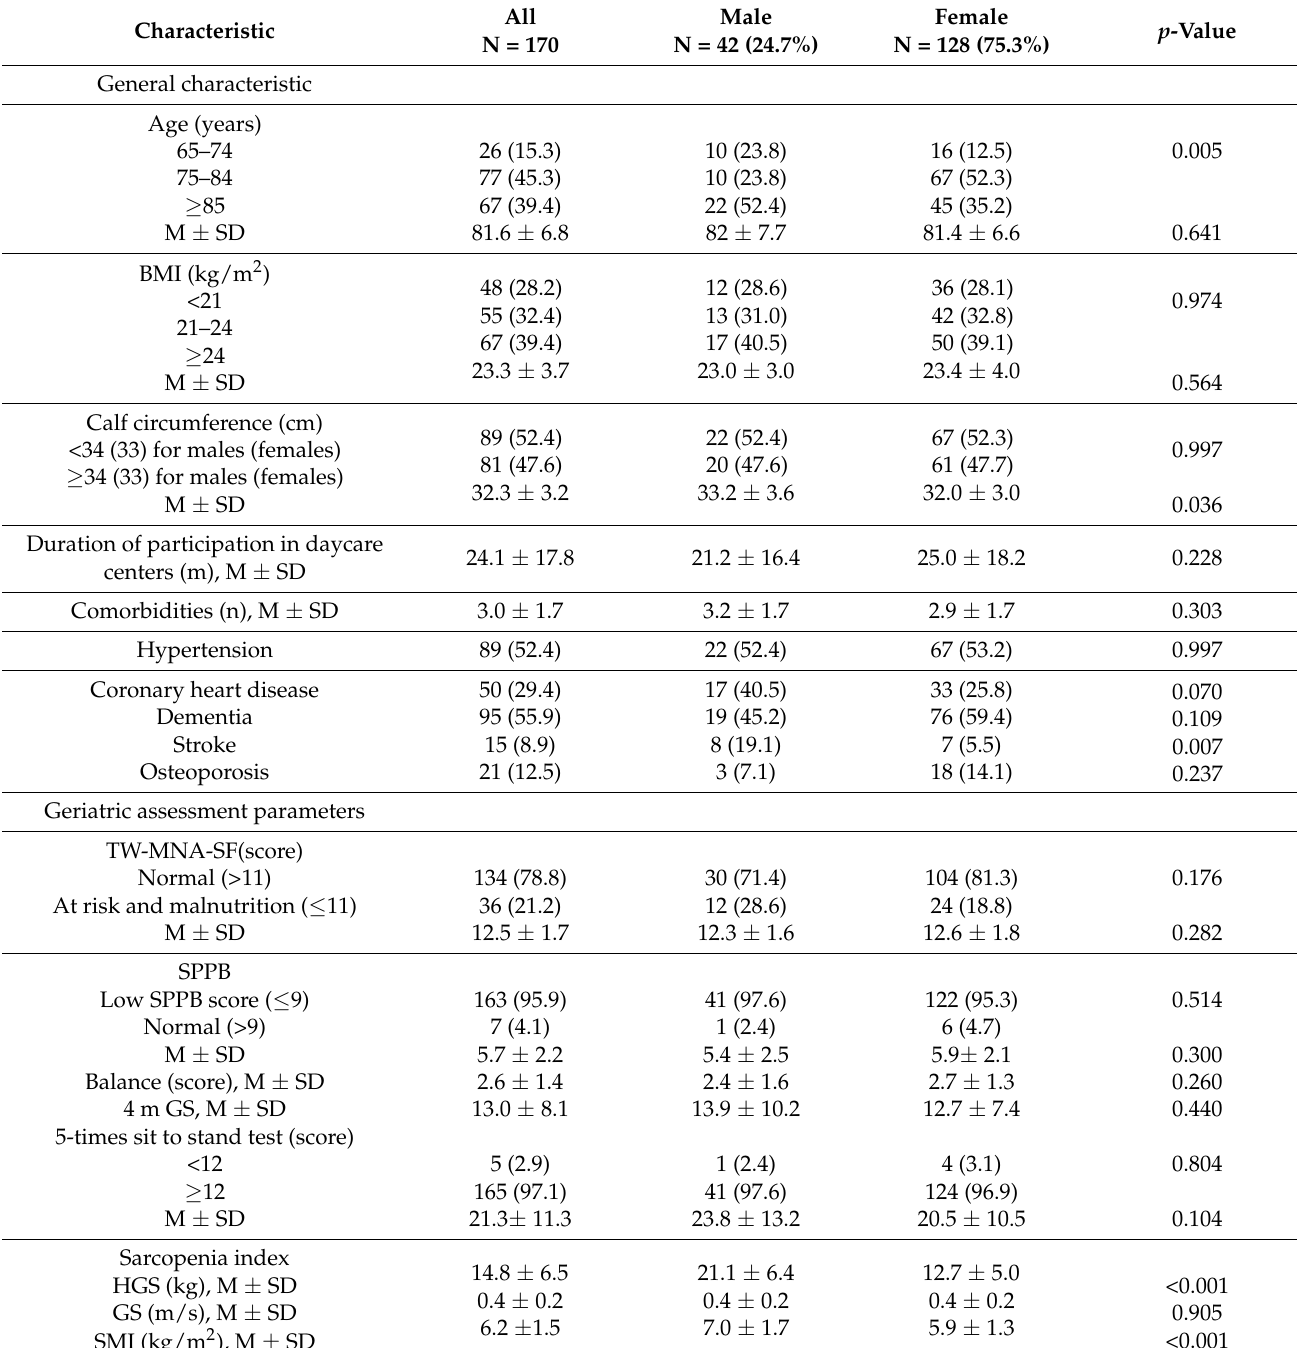
Table 1. Baseline characteristics of the study population, stratified by gender ( n =